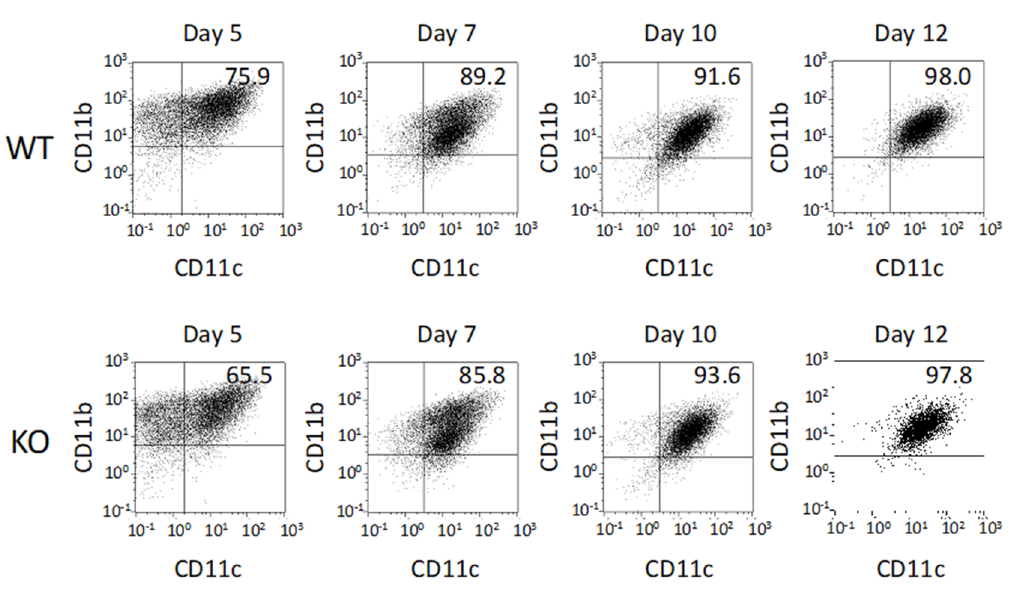
Figure 1. Differentiation of bone marrow derived dendritic cells (BMDCs). BMDCs induced from WT and KO mice were characterized by flow-cytometric analysis after staining with immunofluorescent antibodies against CD11b and CD11c, as described in Materials and Methods. The upper panels show the course of differentiation of BMDCs induced from WT mice and the lower panels that of BMDCs from LRRK2–KO mice. Data are representative of three independent experiments each involving six mice (WT n = 3, KO n = 3).